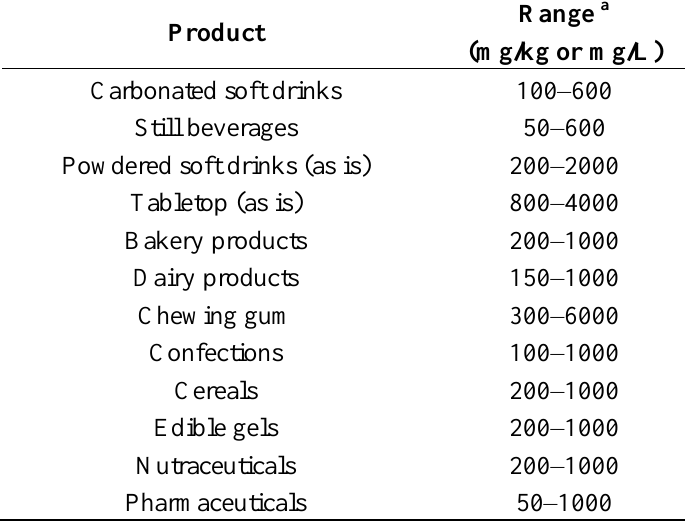
Table 3. Typical rebaudioside M ( 7 ) concentrations used to sweeten various foods and